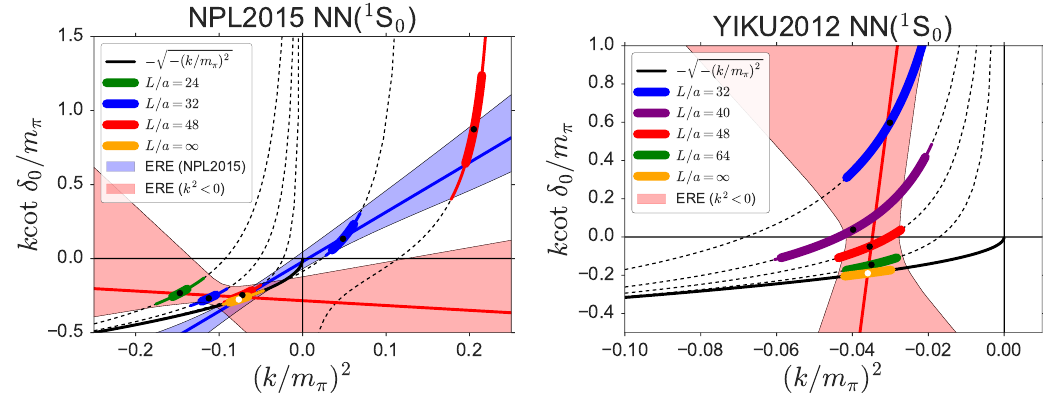
Figure 2 . k cot (cid:14) 0 ( k ) =m (cid:25) as a function of ( k=m (cid:25) ) 2 for NN ( 1 S 0 ) on each volume and the in(cid:12)nite volume in the direct method from ref. [30] (left) and ref. [28] (right). Black dashed lines correspond to L(cid:127)uscher’s formula for each volume, while the black solid line represents the bound-state condition, p (cid:0) (cid:0) ( k=m (cid:25) ) 2 . The red line (with an error band) corresponds to the ERE obtained from the data at k 2 < 0 on (cid:12)nite volumes. In the left (cid:12)gure, the ERE (cid:12)t to the data at k 2 > 0 on (cid:12)nite volumes together with only the in(cid:12)nite volume limit at k 2 < 0 is also shown by the blue line. Both (cid:12)gures from ref.